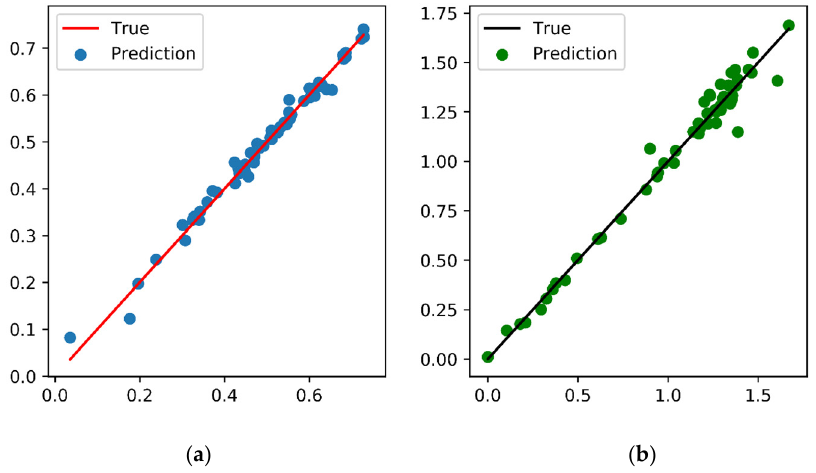
Figure 15. Comparison of the predicted and true values for ( a ) conversion efficiency and ( b ) non-dimensional significant wave force on the barrier at T E = 5 s in irregular waves.